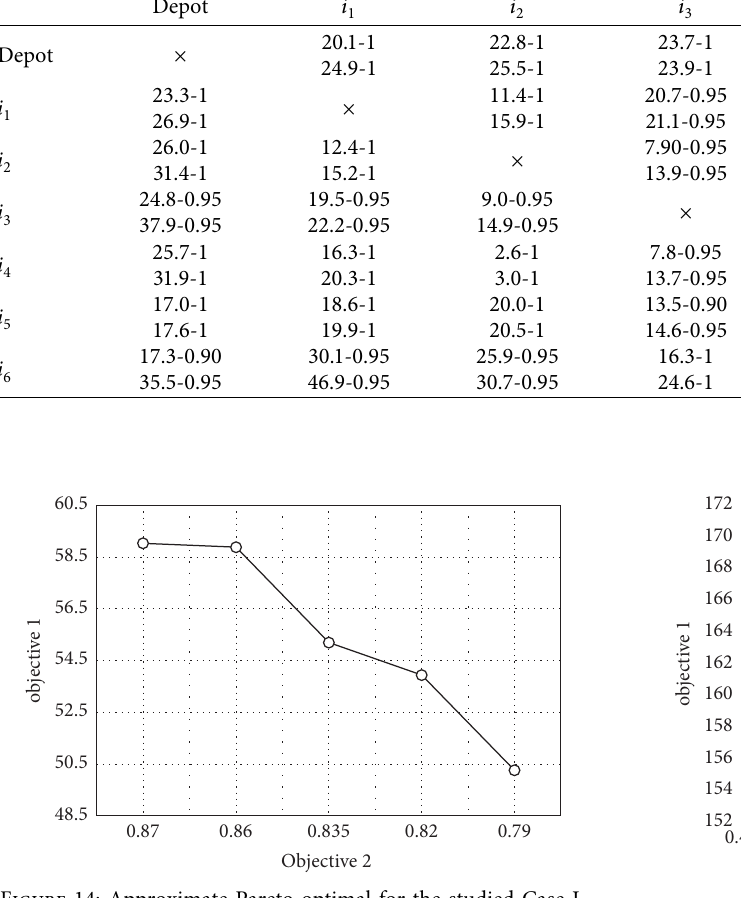
15: Approximate Pareto optimal for the studied Case